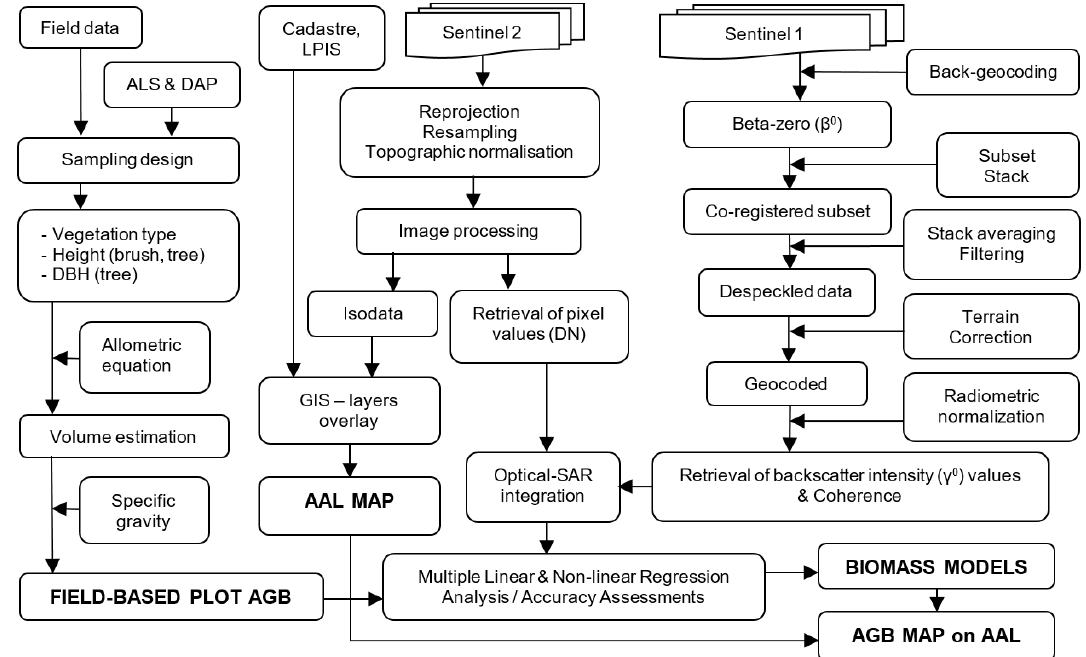
Figure 2. Flowchart of the spatial identification and estimation of AGB on AAL. LPIS, Land Parcel Identification System; ALS, airborne laser scanning; DAP, digital aerial photography.